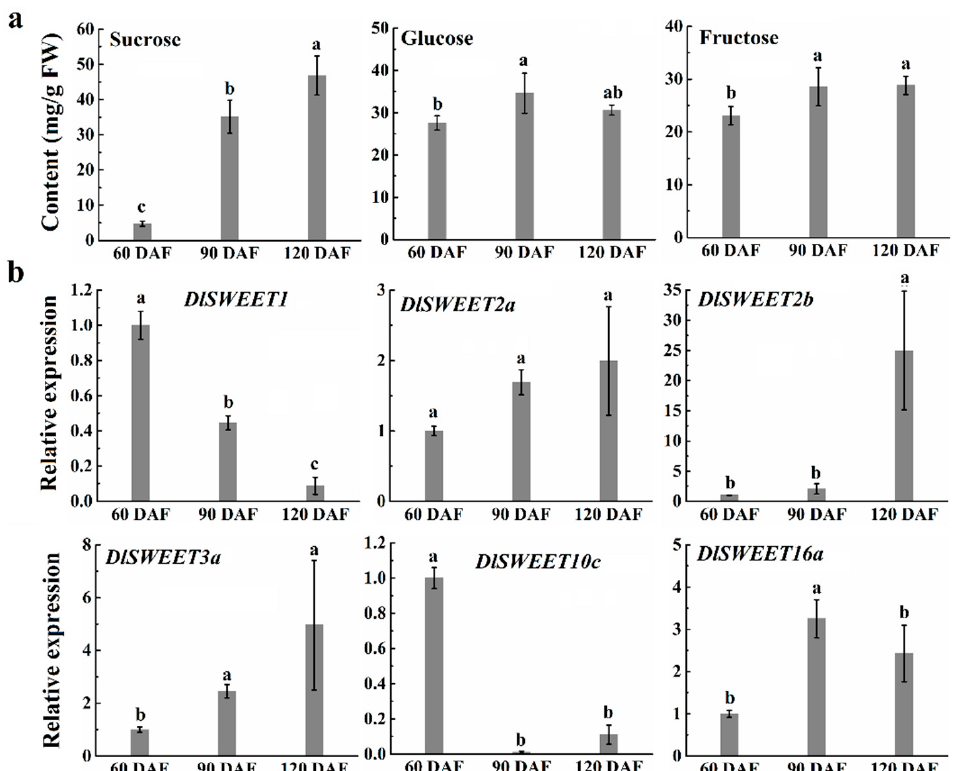
Figure 6. Soluble sugars content and expression profiles of DlSWEET genes during longan fruit development. ( a ) Content of sucrose, fructose, and glucose during “Qingkebaoyuan” fruit development. ( b ) Expression analysis of six DlSWEET genes during “Qingkebaoyuan” fruit development by qRT-PCR analysis. DAF, days after flowering. Values are presented as mean ± standard error (SE) ( n = 3). Means denoted by the same letter are not significantly different at p < 0.05.